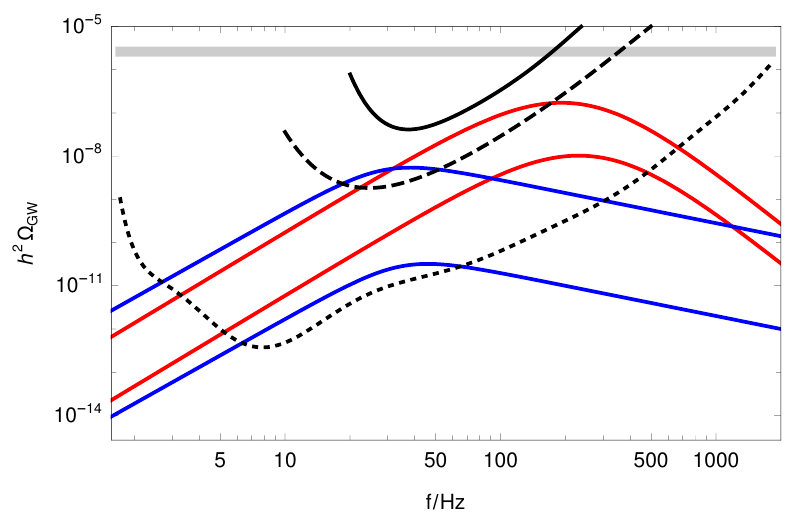
Figure 1 . Sensitivity curves for stochastic GW searches for LIGO with O1 and O2 data (solid black), for design LIGO (dashed) and for ET (dotted). The thick gray line is the indirect upper bound from Planck CMB data. We also show two representative power spectra arising in the PQ model of section 3.2.1, corresponding to the points ‘ p 2 ’ and ‘ p 3 ’ of (cid:12)gure 5. They have respectively F a = 10 8 GeV with (cid:11) (cid:25) 3 : 5, and F a = 10 9 GeV with (cid:11) (cid:24) 10 6 . We have set v w = 1 and show the signals which arise from only bubble wall collisions with (cid:20) (cid:30) = 1 (blue lines) and from only sound waves in the plasma with (cid:20) sw = 1 (red